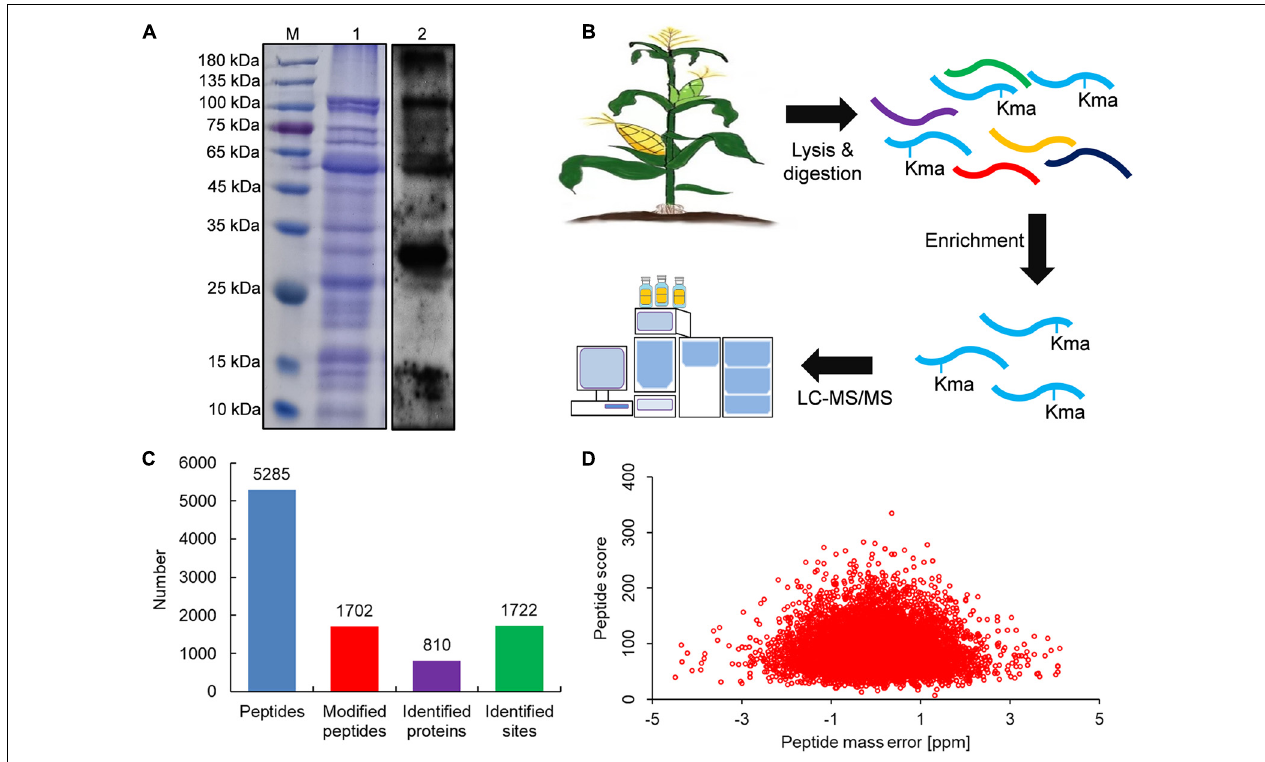
FIGURE 1 | Global identification of lysine malonylation sites in maize. (A) SDS-PAGE (1) and signal in immunoblotting with antimalonyllysine antibody (2). (B) Work procedure used in this study. (C) Number of malonylated proteins and sites in maize. (D) Distribution of peptide mass